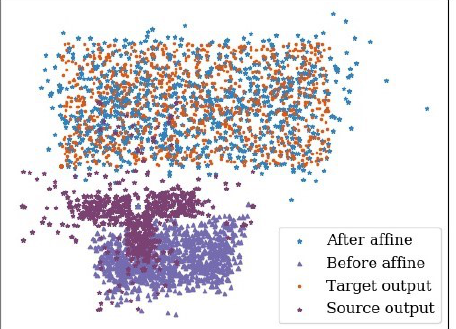
Figure 8. Affection of the proposed affine layer for the